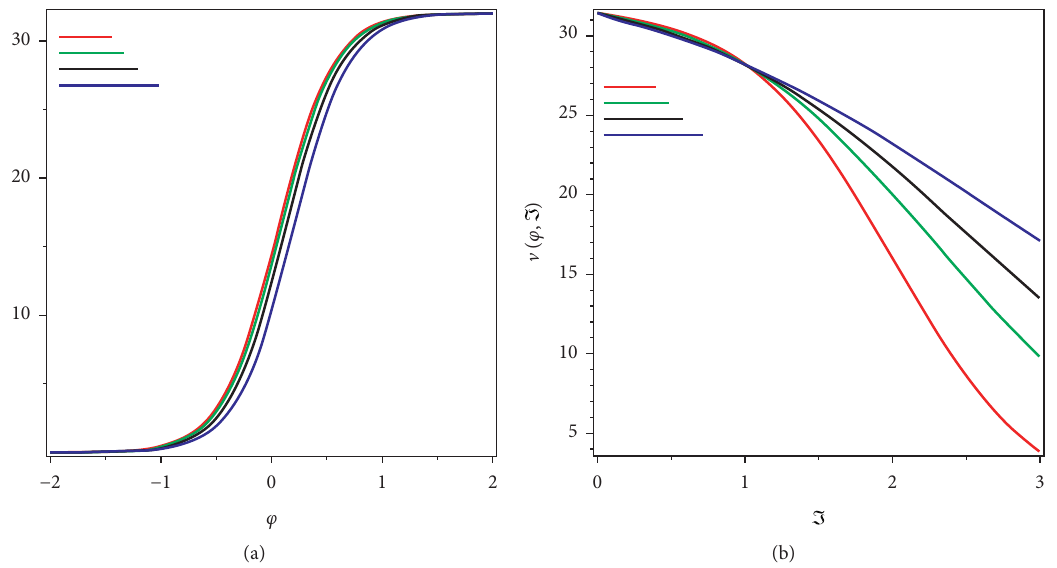
Figure 8: The different fractional-order solution with respect to the Atangana–Baleanu operator of ] ( φ , I ) at β of Example 3.